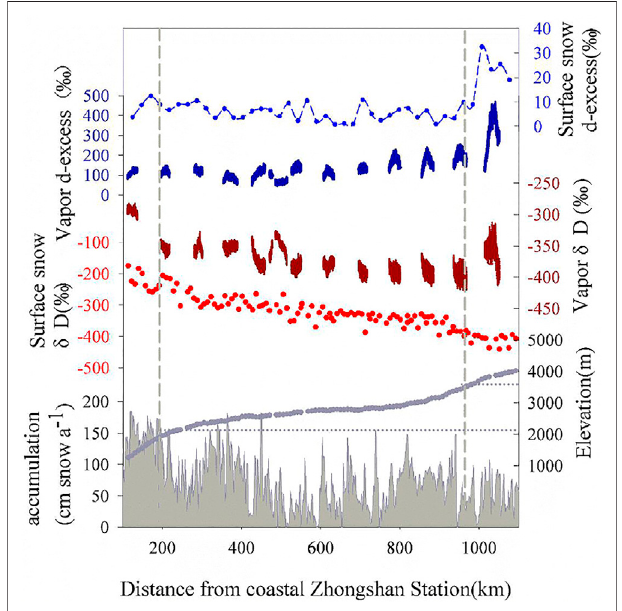
FIGURE 3 | Synthesis multi-index comparison of isotopes and accumulation along transect from Zhongshan to Dome A, all these coincidently shows three climatic regimes, which controls the circulation and isotopic fractionation of the water cycle.